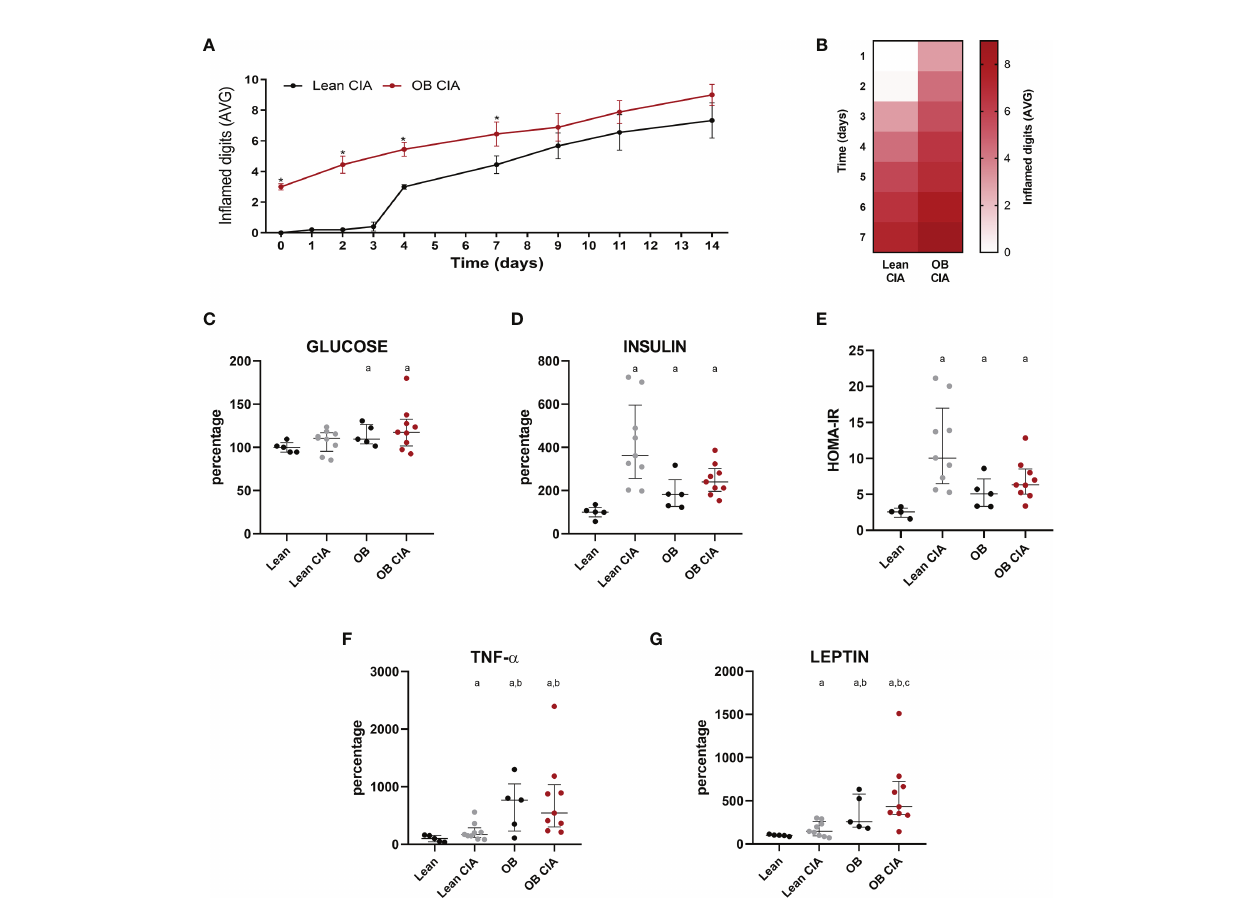
FIGURE 1 | Obesity accelerates the arthritis onset: in fl ammatory and metabolic changes in mice. (A) Mean number of in fl amed digits during disease progression in lean and OB CIA mice. Signi fi cance was determined by Student t-test (unpaired), (B) Heatmap showing the mean number of in fl amed digits during arthritis progression in lean and OB CIA mice. (C) Plasma glucose levels in lean, lean CIA, obese, and obese CIA mice, (D) Plasma insulin levels in lean, lean CIA, obese, and obese CIA mice, (E) HOMA-IR of lean, lean CIA, obese, and obese CIA mice, (F) Plasma TNF- a levels in lean, lean CIA, obese, and obese CIA mice, and (G) Plasma leptin levels of lean, lean CIA, obese, and OB CIA mice. CIA, collagen induced arthritis; OB, obese; HOMA-IR, homeostatic model assessment – insulin resistance; TNF- a , tumor necrosis factor alpha. Signi fi cance was determined by one-way ANOVA followed by Ducan post hoc test (C – G) . *Signi fi cant differences vs. lean CIA (p < 0.05). a Signi fi cant differences vs. lean (p < 0.05). b Signi fi cant differences vs. lean CIA (p < 0.05). c Signi fi cant differences vs. OB (p <